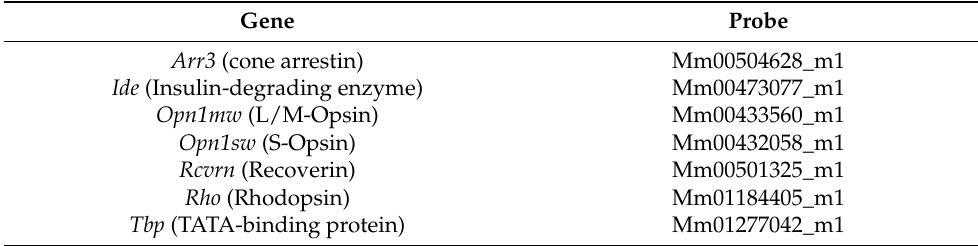
Table 1. TaqMan assays used in the experiments. Gene Probe Arr3 (cone